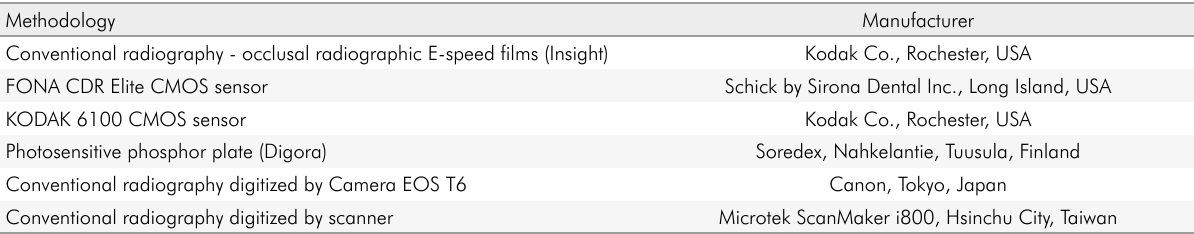
Table 1. Radiographic acquisition methodologies and